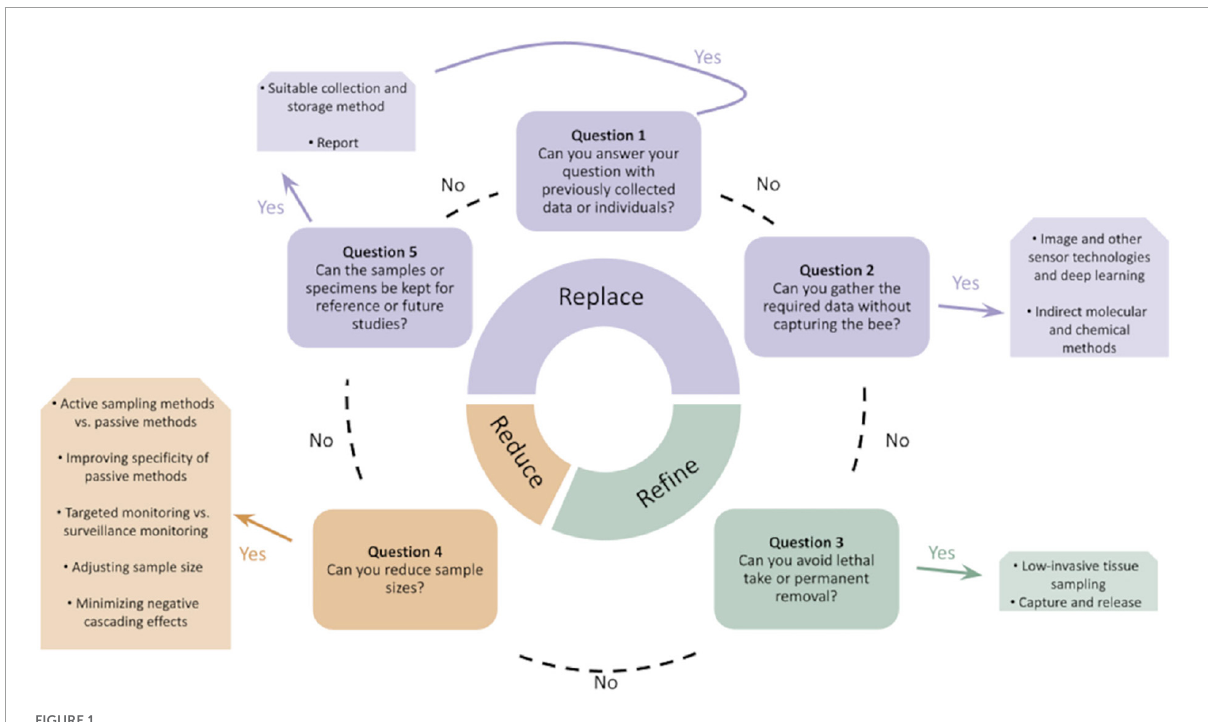
FIGURE1 Decision-making framework for replacing, refining, and reducing lethal bee captures in monitoring programs, reproduced from Montero-Castaño et al. (2022) (CC BY